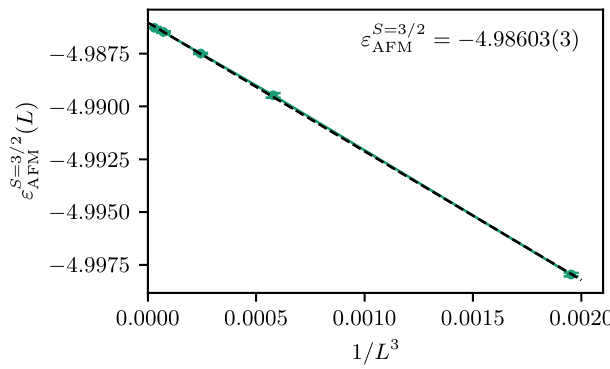
= 3 / 2 ( L ) of the spin-3 / 2 Heisenberg model. AFM